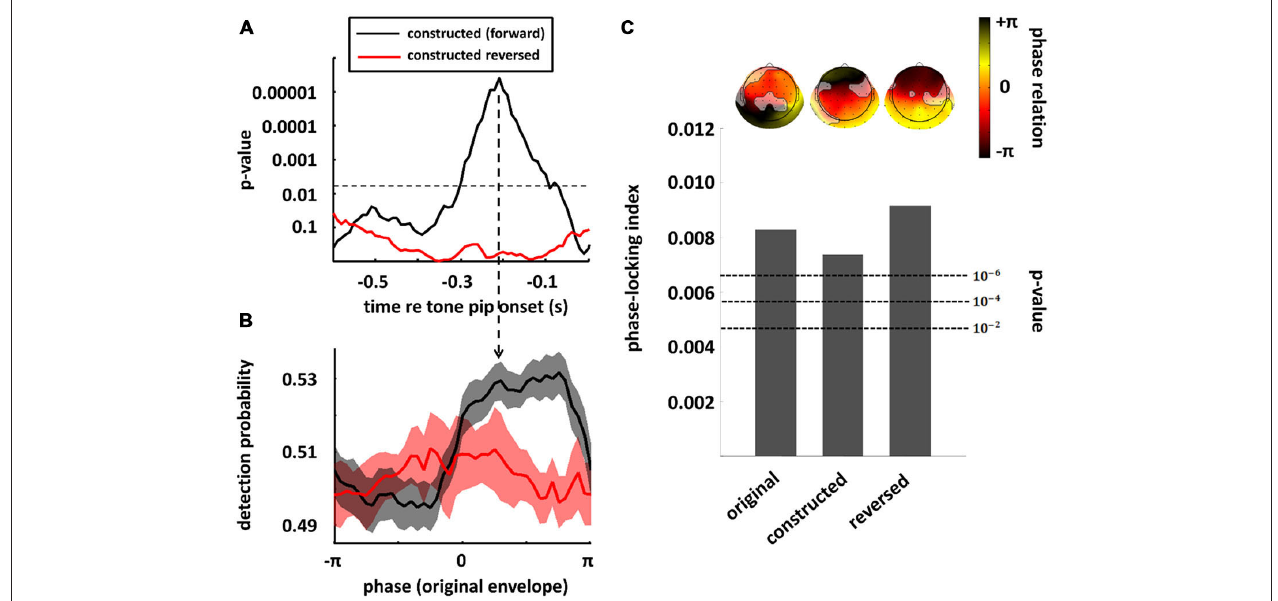
FIGURE 4 | Perception and neural oscillations entrain to high-level features of speech sound. Speech/noise stimuli without systematic fluctuations in amplitude or spectral content were constructed, whose high-level features are conserved and reflected by the original speech envelope (cf. Figure 3 ). In a psychophysical study (A,B) , the detection of a tone pip was significantly modulated by those high-level features (black; in this plot, results obtained in the original experiment and a follow-up replication have been combined; both experiments are described in Zoefel and VanRullen, 2015b). The significance of this modulation is shown in (A) for different time lags relative to target onset, whereas the actual performance (at the time lag indicated by the vertical arrow in (A) is shown in panel (B) . This effect was abolished when the speech/noise sound was reversed (red), indicating an important role of linguistic features (i.e., intelligibility) for behavioral consequences of the entrainment. In (A) , the significance threshold is shown as a dashed line (corrected for multiple comparisons). In (B) , standard error of mean (SEM) is shown by contours around the lines. When the same stimuli (and their original version of everyday speech) were presented in an EEG experiment (C) significant phase-locking between original speech envelope and EEG signal could be observed in all conditions (original, speech/noise sound and reversed speech/noise sound), suggesting that high-level features can entrain the phase of EEG oscillations, and do so even if the speech is unintelligible (note that acoustic high-level features remain present in the speech/noise sound, even when it is reversed, as the listener can still differentiate speech and noise). Bars show the average phase-locking across EEG channels, whereas the actual phase differences between EEG signal and original speech envelope, separately for each channel, are shown as insets above the bars (channels without significant entrainment are shaded out). P -values of phase entrainment, obtained by permutation tests, are shown as dashed lines. Note that, in contrast to the degree of entrainment which is comparable in all three conditions, the entrained phase does differ between everyday speech sound (original condition) and speech/noise sound in which systematic fluctuations in low-level features have been removed (constructed and constructed reversed conditions). Modified with permission from Zoefel and VanRullen (2015b) (A,B) and Zoefel and VanRullen (2015a), copyright Elsevier